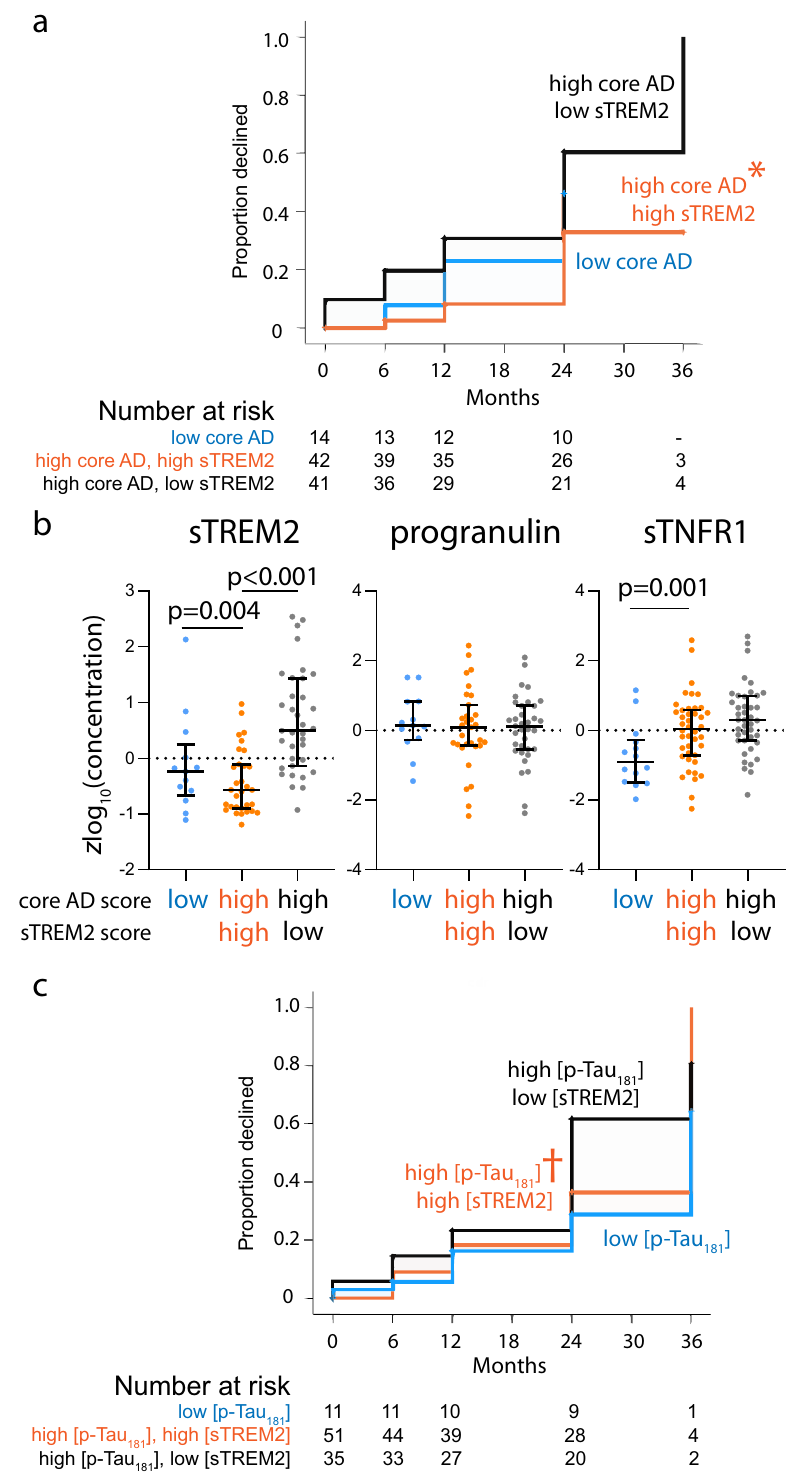
Fig. 2 Relationship between two protein family scores (core AD and sTREM2) and cognitive decline in AD dementia. AD dementia participants with high core AD and sTREM2 scores had slower conversion to a pre-set CDR-SB threshold (1.5 S.D. above the mean) than participants with low sTREM2 scores ( a * p = 0.001). Concentrations of two proteins which did (sTREM2 and progranulin) and one did not (sTNFR1) load onto sTREM2 score showed greatest group-level differences in sTREM2 ( b median and interquartile ranges shown). Substituting corresponding p-Tau 181 and sTREM2 concentrations (shown in brackets to distinguish from a ) for corresponding scores modestly reproduced the distinction ( c † p = 0.028). Source data are provided as a Source Data fi